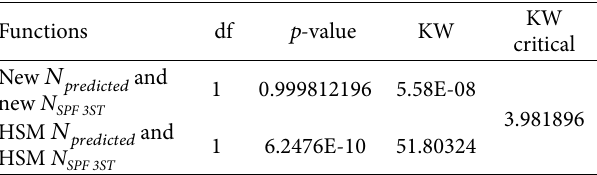
Figure 2: Residuals analysis diagrams and performance of the new functions reflecting local data. Legend: the gray points represent the residuals between the values predicted adopting the HSM default functions and the observed values; the black points represent the residuals between values predicted adopting the local SPF and the observed Table 6: KW test results.